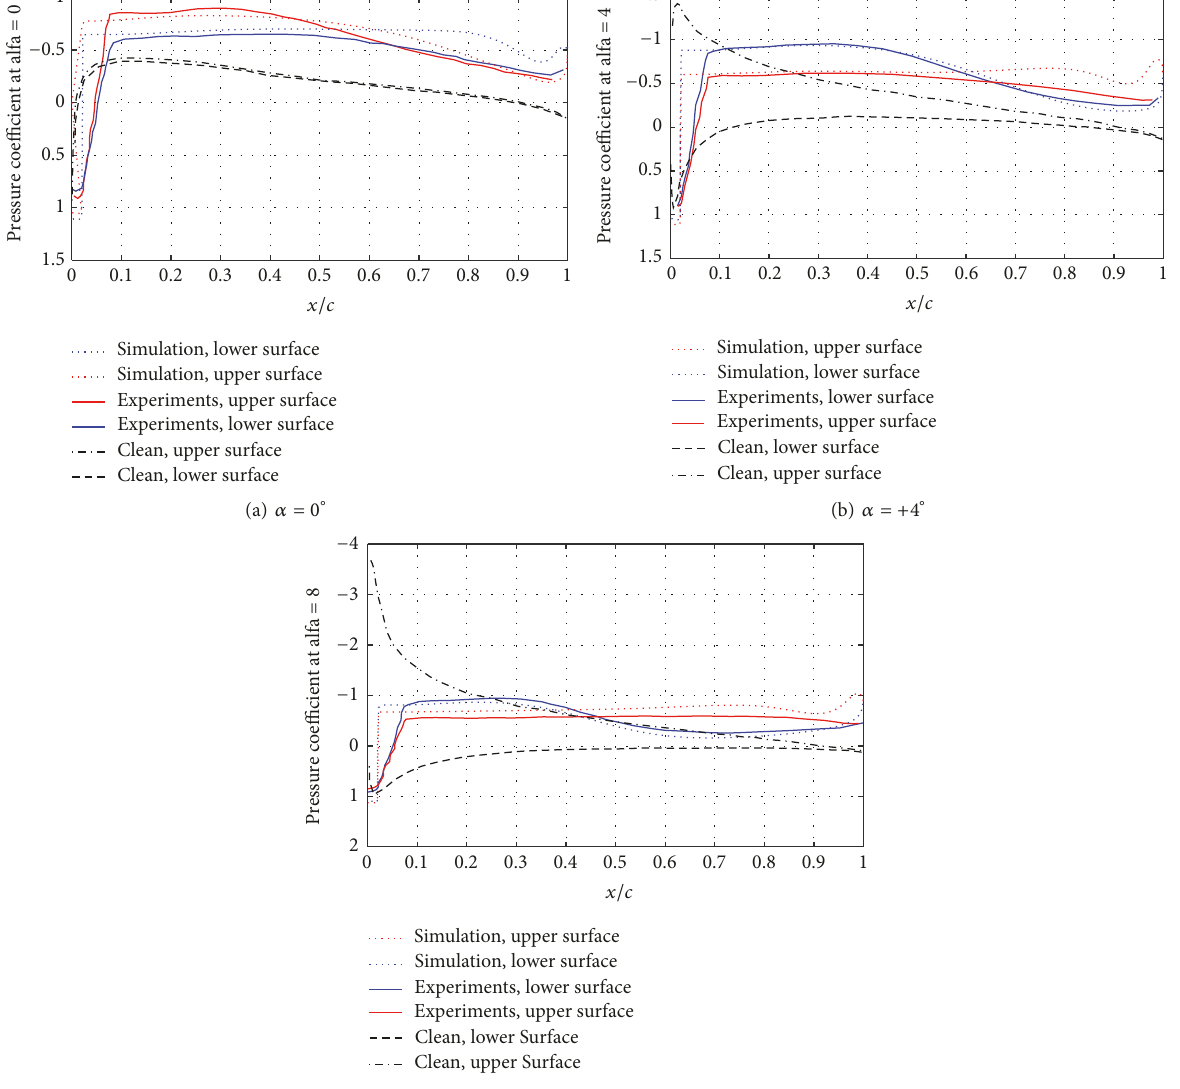
at the separated region. Therefore, a negative lift is produced at 58% of the chord length based on the experiments (from 𝑥/𝑐 = 0.08 to 0.65). The lift is then positive until the last 4% (𝑥/𝑐 = 0.96) where the trailing edge vortex is